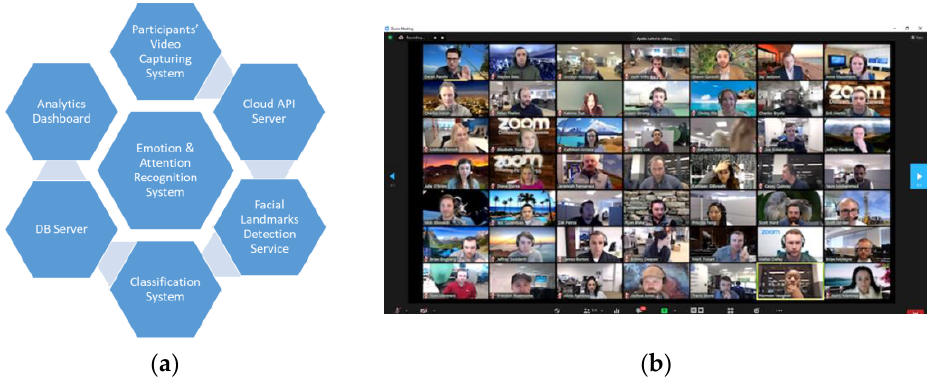
Figure 1. Proposed solutions for the crowded video conference: ( a ) proposed participant monitoring system design; ( b ) an overcrowded video conference (source: Google photos).